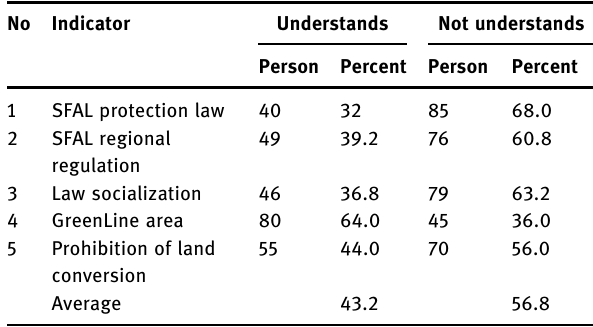
Table 1: Farmers ’ Knowledge of Sustainable Food Agricultural